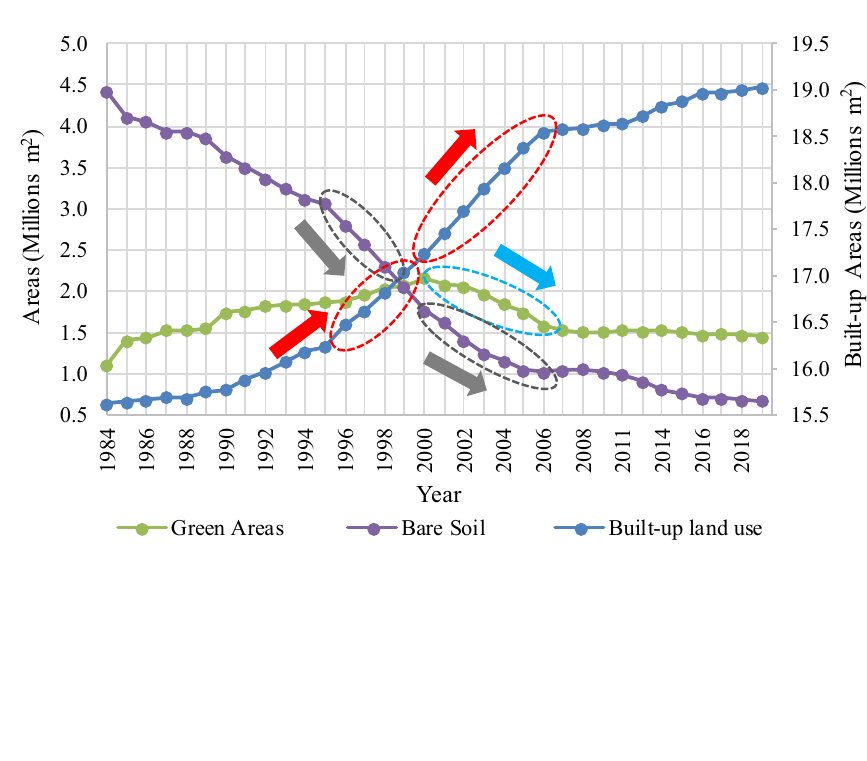
Fig. 10 Land use dynamics in Beirut